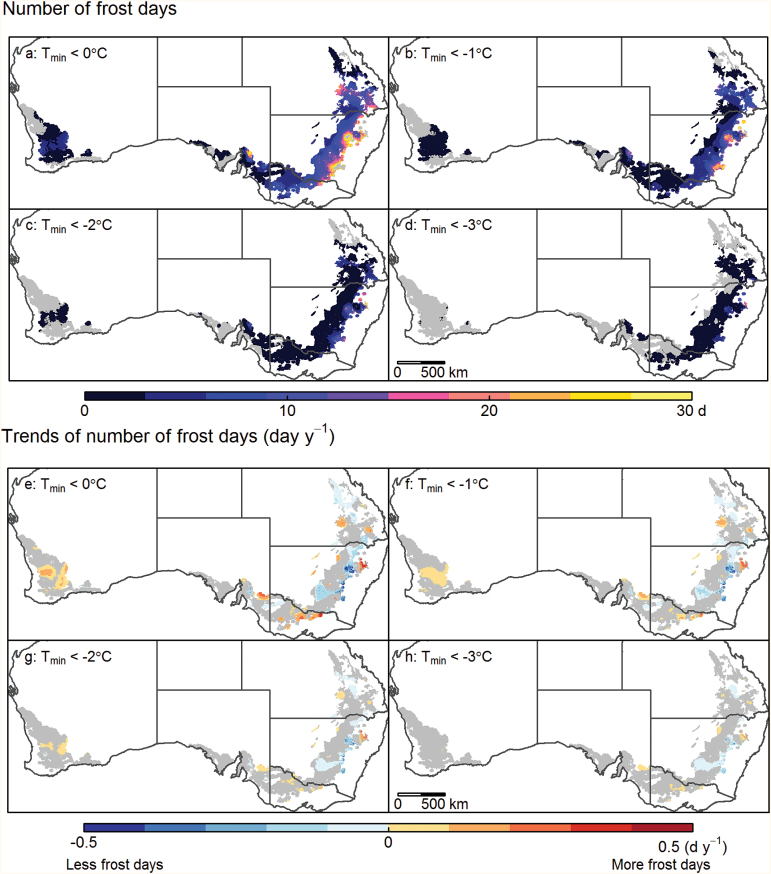
Maps of the average annual number of frost days over the 57 years from 1957 to 2013 (a–d) and the temporal trend of number of frost days (e–h) for minimum temperature (T
min) thresholds of 0 °C (a and e), –1 °C (b and f), –2 °C (c and g), and –3 °C (d and h) across the Australian wheatbelt. The grey shading in (a–d) indicates ‘frost-free’ regions where frost at the specified temperature threshold occurred in <10% of years and in (e–h) regions where trends in number of frost days were not significant (P>0.1) or for which there were <10% years with frost.